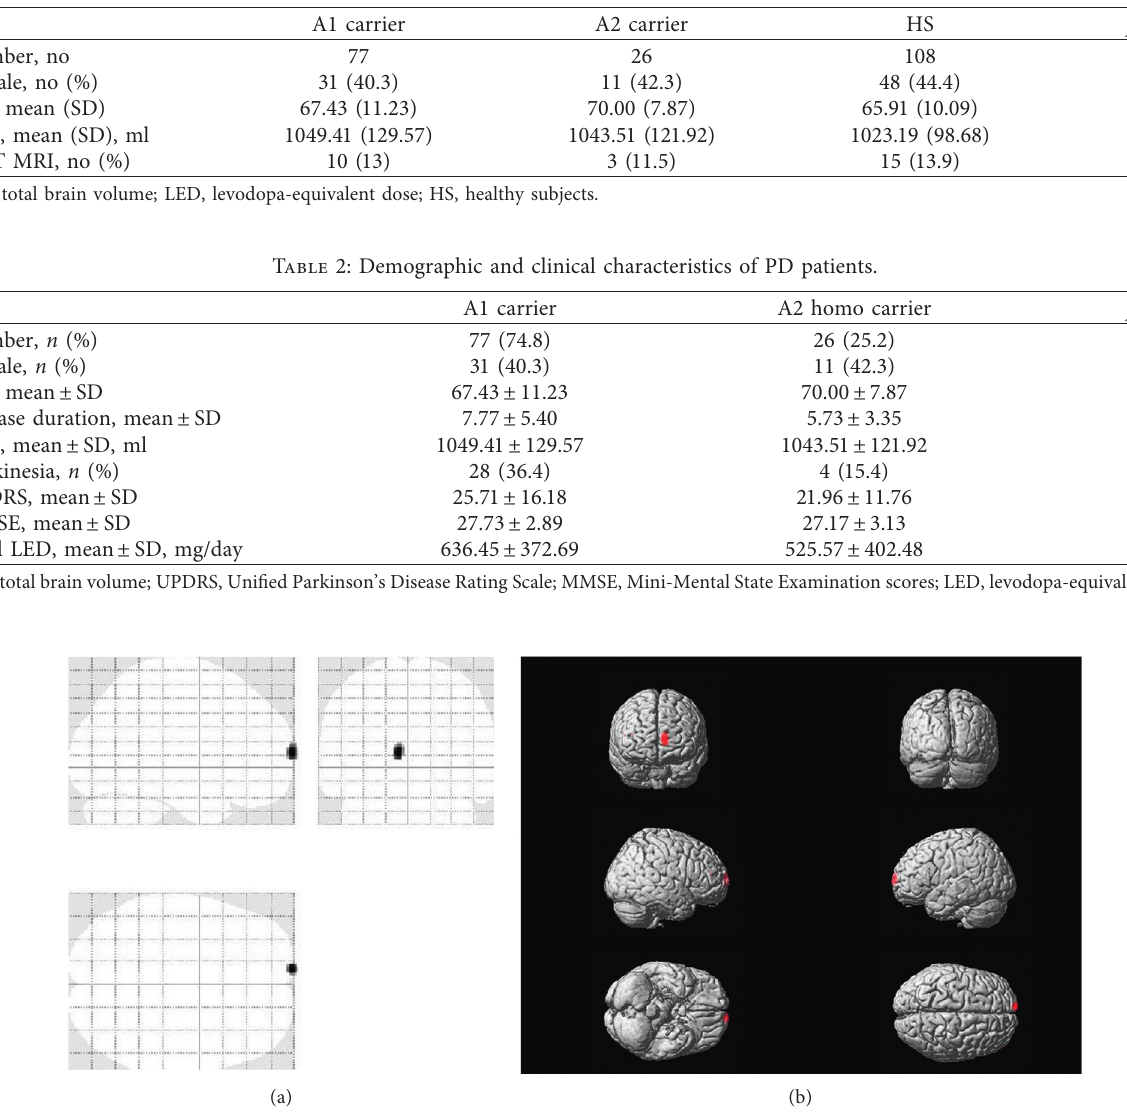
Table 1: Demographic and clinical characteristics of participants.